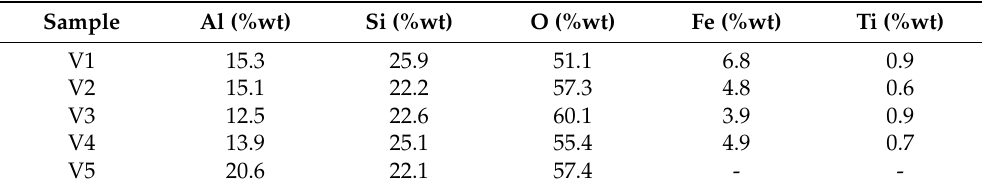
Figure 8. (left) SEM image of V1 ( a ), V2 ( h ), V3 ( o ), and V4 ( v ) samples. Second row corresponding to EDS mapping region for above samples ( b , i , p , w ). Elemental (Fe, Al, Si, Ti, and O) constitution for the analyzed samples ( c – bl ). V5 represents pure zeolite 5A. (right) EDS spectrum for V samples. Table 4. Quantitative atomic composition found in soil samples. Errors represents ± 0.1 of estimated